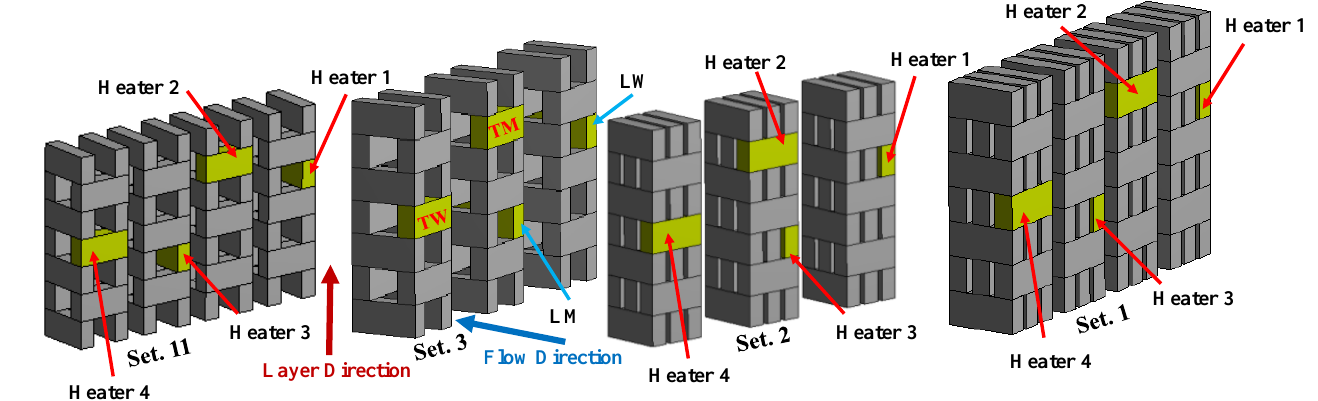
Figure 1. Demonstrates the fifth row in the four examined settings [14]. Table 1. Features of the current settings [14].